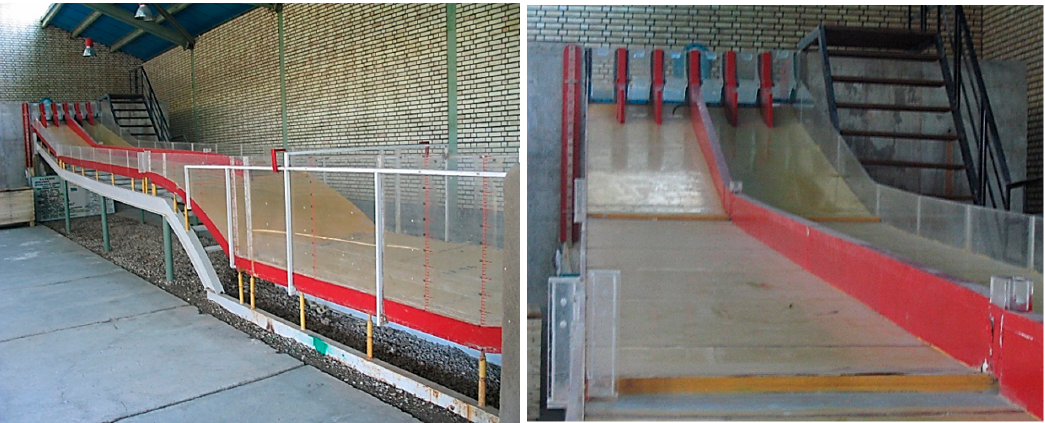
Figure 15. The 1/64 scale model of the Karkheh Dam’s spillway. Figure 15. The 1 / 64 scale model of the Karkheh Dam’s